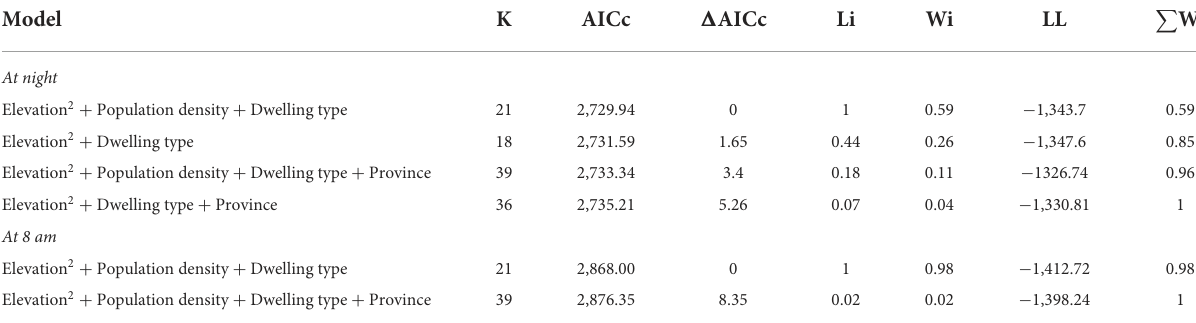
TABLE 5 Reduced candidate model list of models < 10 1 AICc ranked using Akaike Information Criterion (AIC) to explain where owned dogs were confined at night and at 8 am according to dogs owners of Costa Rica.